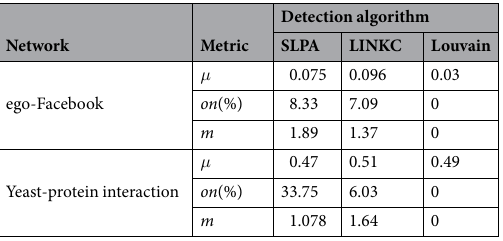
Table 2. The estimated mixing parameter μ , the proportion of the overlapping nodes on , and the average number of the community membership m in ego-Facebook and Yeast-protein interaction